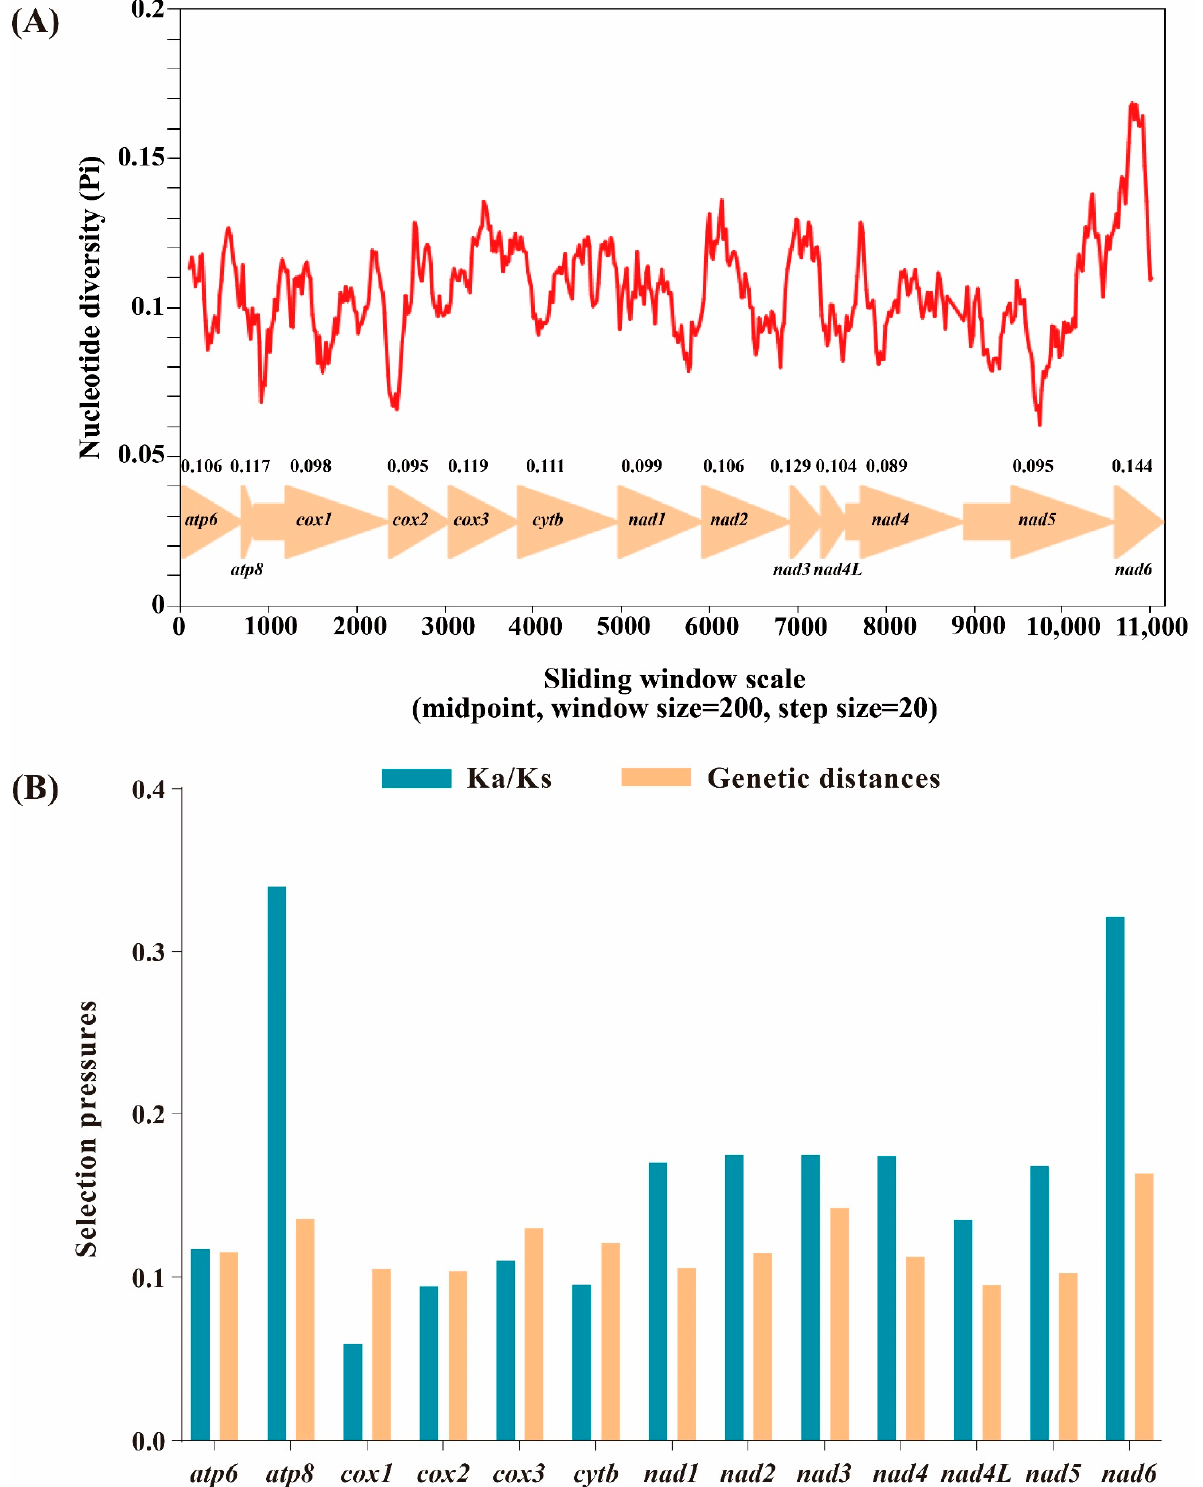
Figure 3. Nucleotide diversity and selection pressures on 13 PCGs in Limenitidinae. ( A ) Sliding window analysis of the alignment of 13 protein-coding genes. The value of nucleotide diversity (Pi) is indicated by the red curve. Pi values and genes are indicated below the red curve. ( B ) Genetic distances and non-synonymous (Ka) to synonymous (Ks) substitution rates of 13 protein-coding genes among 58 Limenitidinae species.